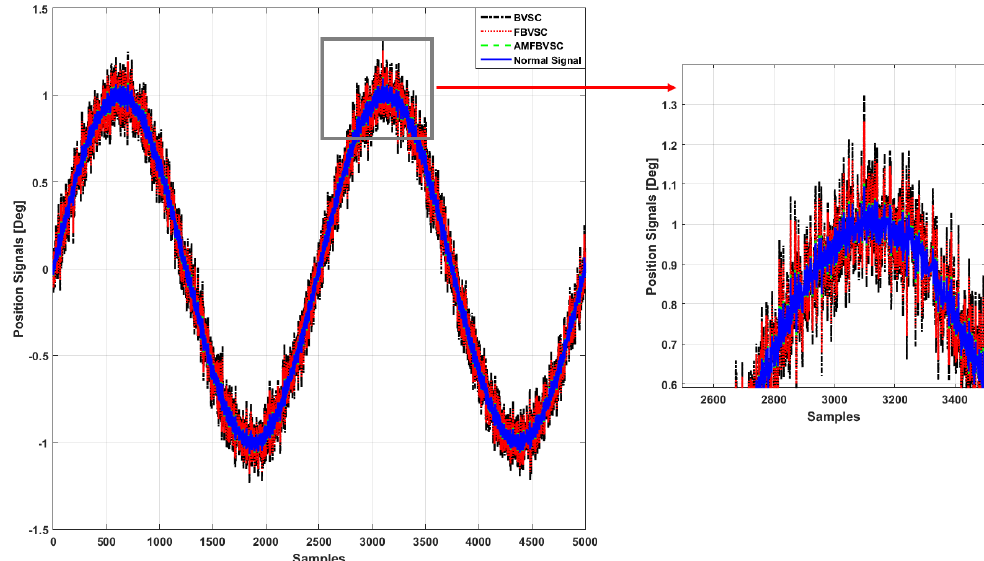
Figure 8. Fault-tolerant control algorithm based on the proposed active modern fuzzy backstepping variable structure controller (AMFBVSC), fuzzy backstepping variable structure controller (FBVSC) and backstepping variable structure controller BVSC.